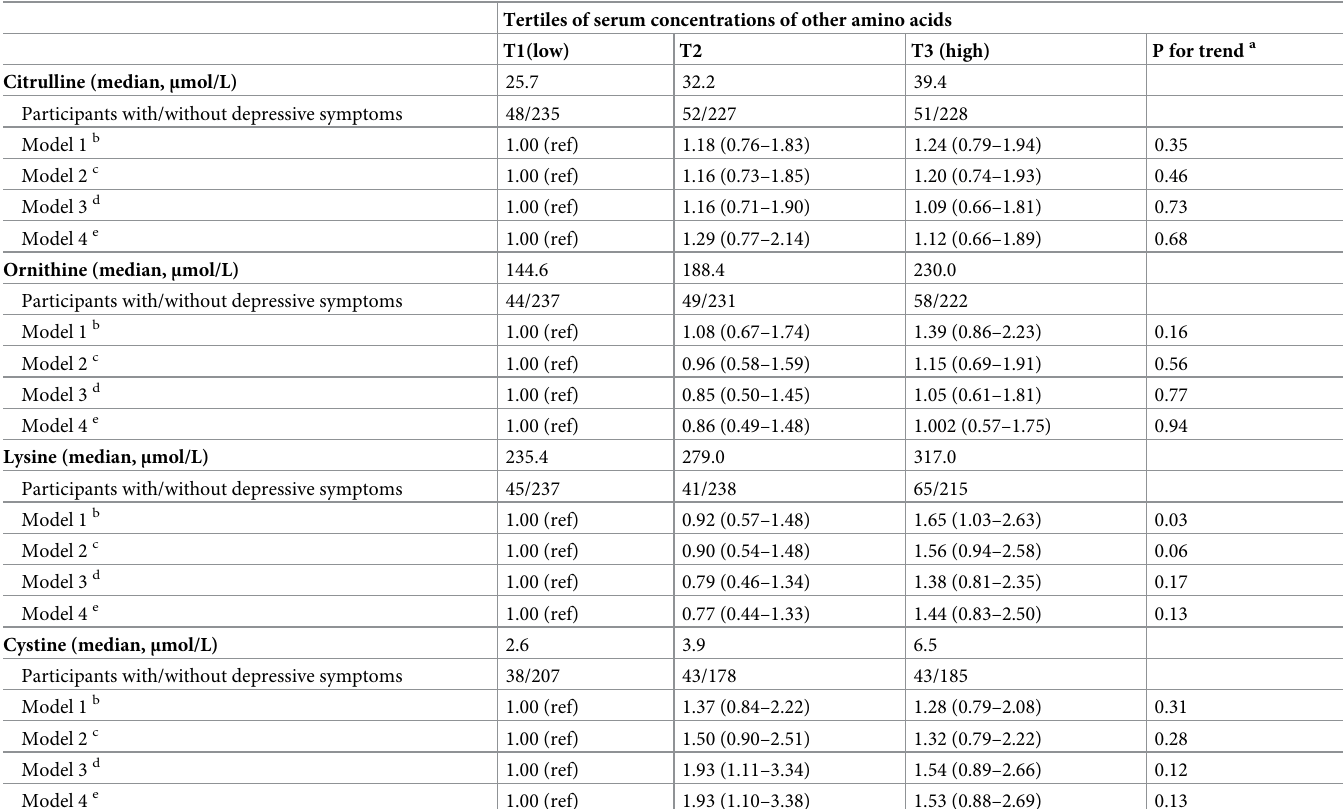
Table 6. Associations of serum concentrations of other amino acids with depressive